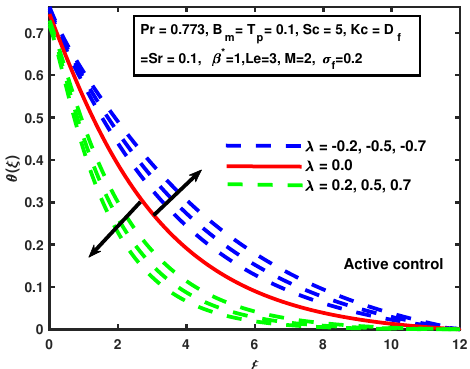
Figure 9. The impact of θ ( ξ ) on suction/injection λ (active control